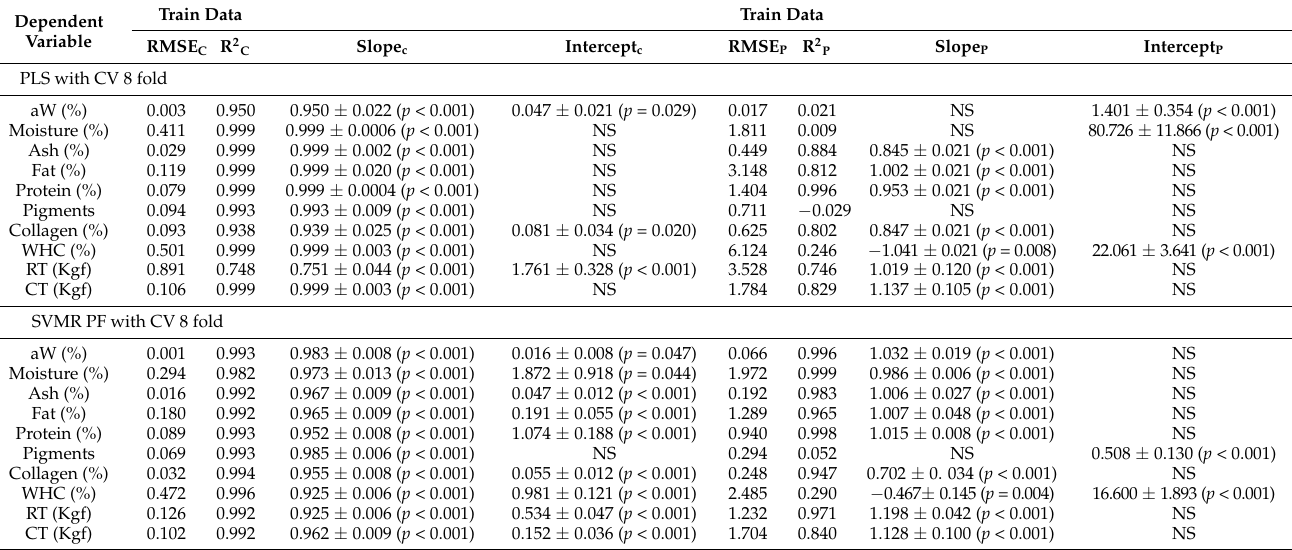
Table 3. The predictive results of the models for the training and test